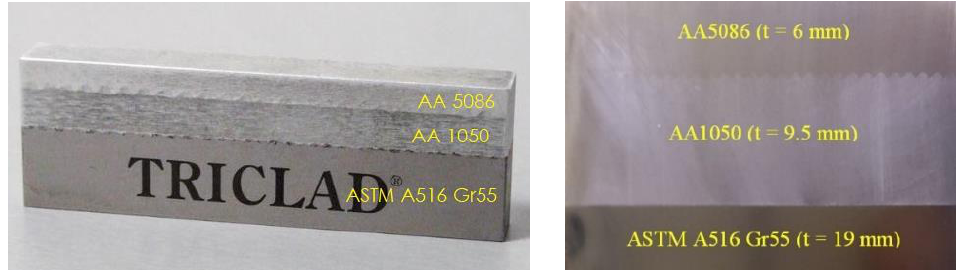
Figure 2. Al/Fe explosion-welded joint included in the tested structure.